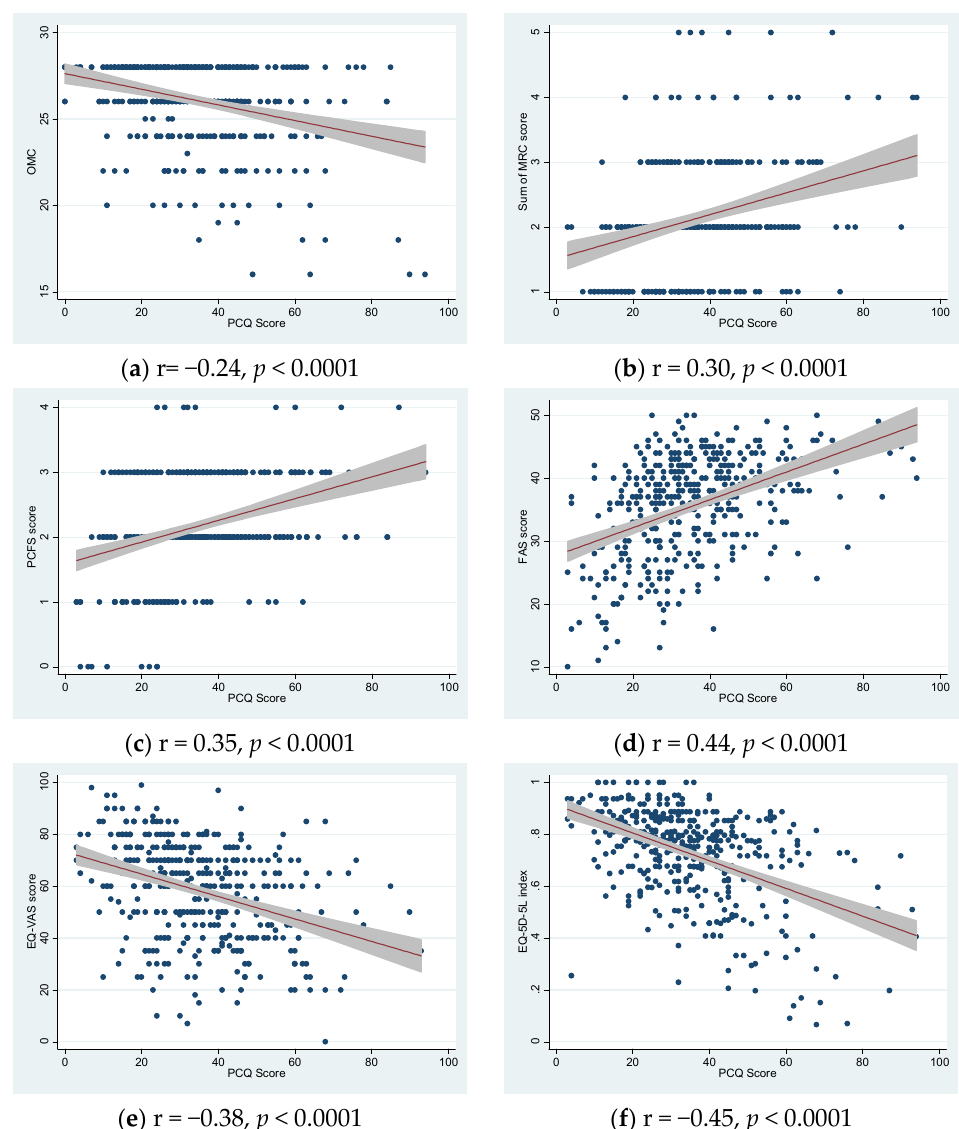
Figure 1. Correlation plots comparing post-COVID symptom questionnaire (PCQ) with validated health scores (( a ) OMC, ( b ) MRC dyspnea, ( c ) PCFS, ( d ) FAS, ( e ) EQ-VAS and ( f ) EQ-5D-5L index). PCQ Score: sum of all 31 registered symptom scores (0–124). OMC: Orientation Memory test (0–28). MRC: Medical Research Council dyspnea score (1–5). PCFS: Post ‐ COVID